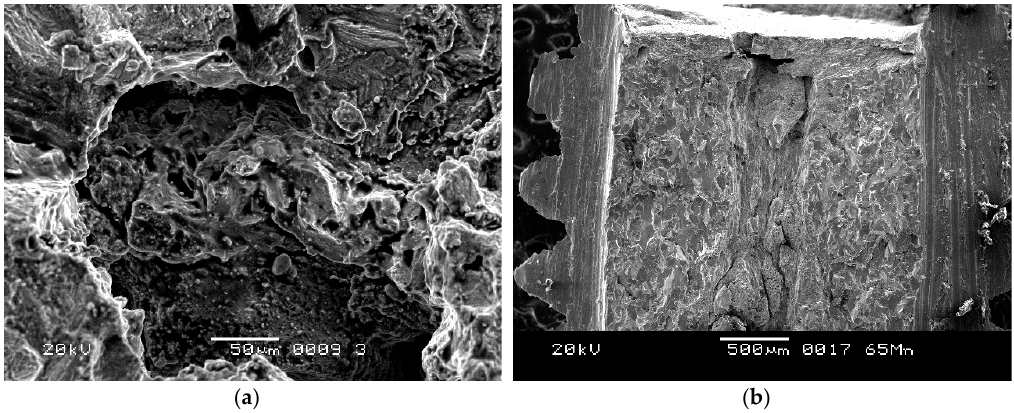
Figure 9. ( a ) Oxidation fracture morphology; ( b ) Morphology along the axial direction.